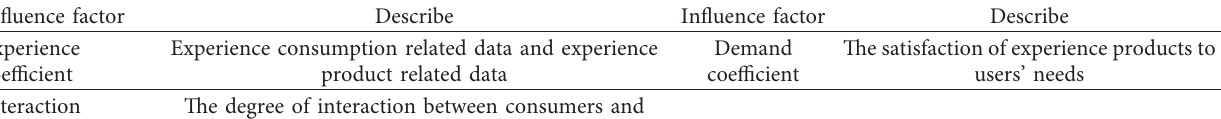
Table 1: Influencing factors of experience consumption ability under the theory of aesthetic economy.